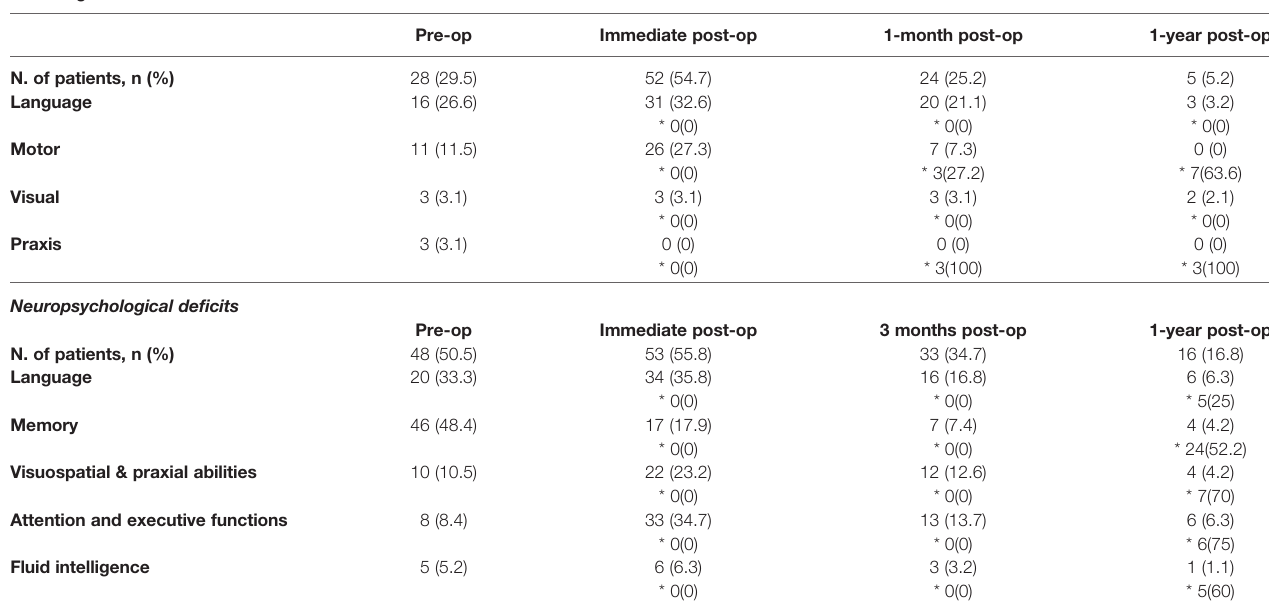
TABLE 2 | Neurological and neuropsychological de fi